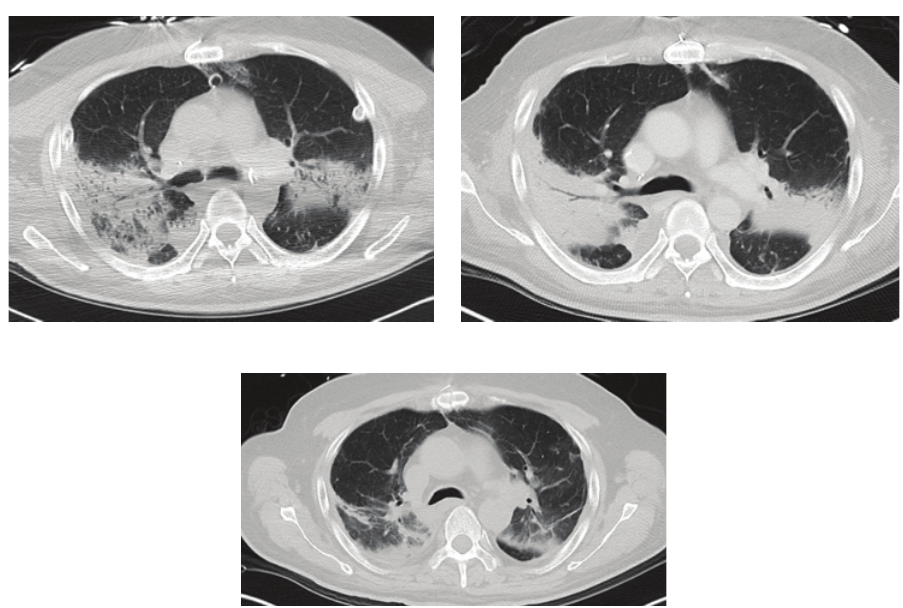
Figure 1: Serial chest CT imaging prior to and after treatment with amphotericin. The first image shows the patient’s chest at day +12 after transplantation with significant disease in the dependent areas of the lungs bilaterally that has progressed to dense consolidation by day +25 (3 days prior to diagnosis) as the second figure shows while the third image shows the patient’s chest imaging at day +90 with significant